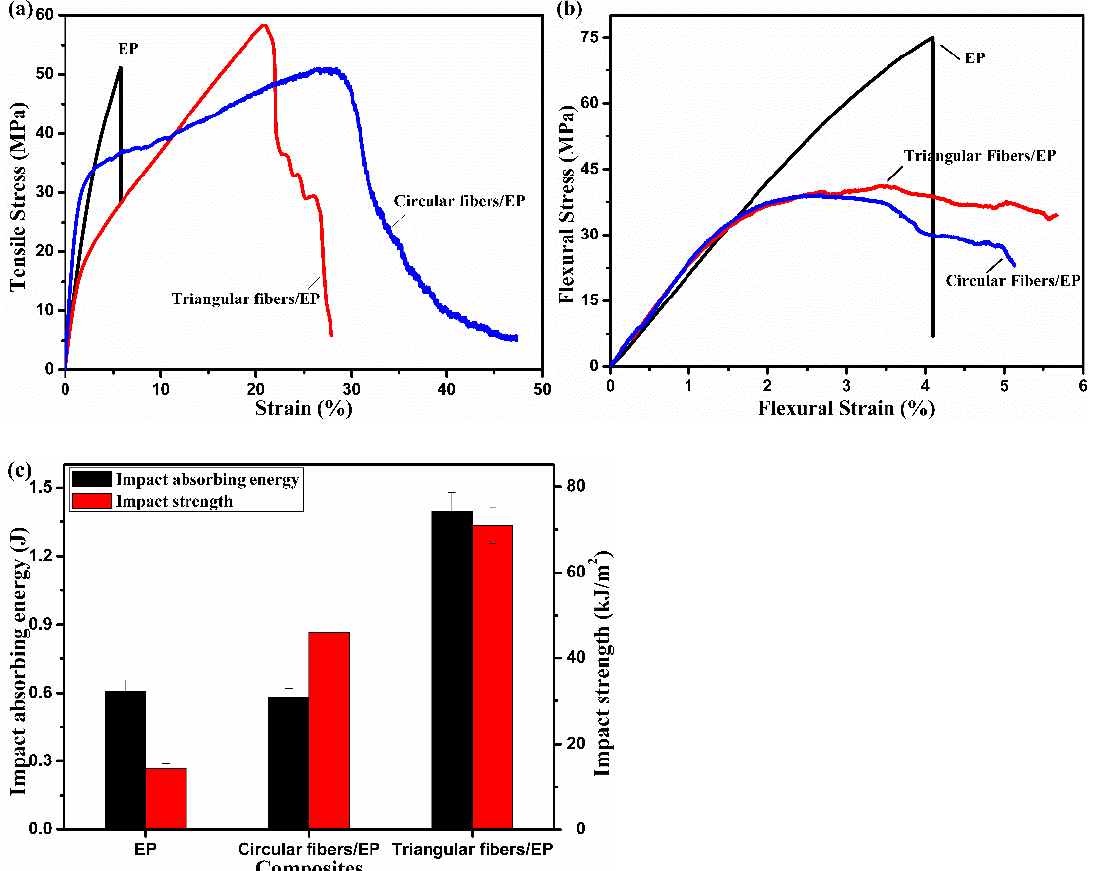
Figure 8. ( a ) Tensile, ( b ) flexural and ( c ) impact properties of EP and PVA/EP composites with different fibers. Table 1. The mechanical strength averages of EP and PVA/EP composites with different fibers.